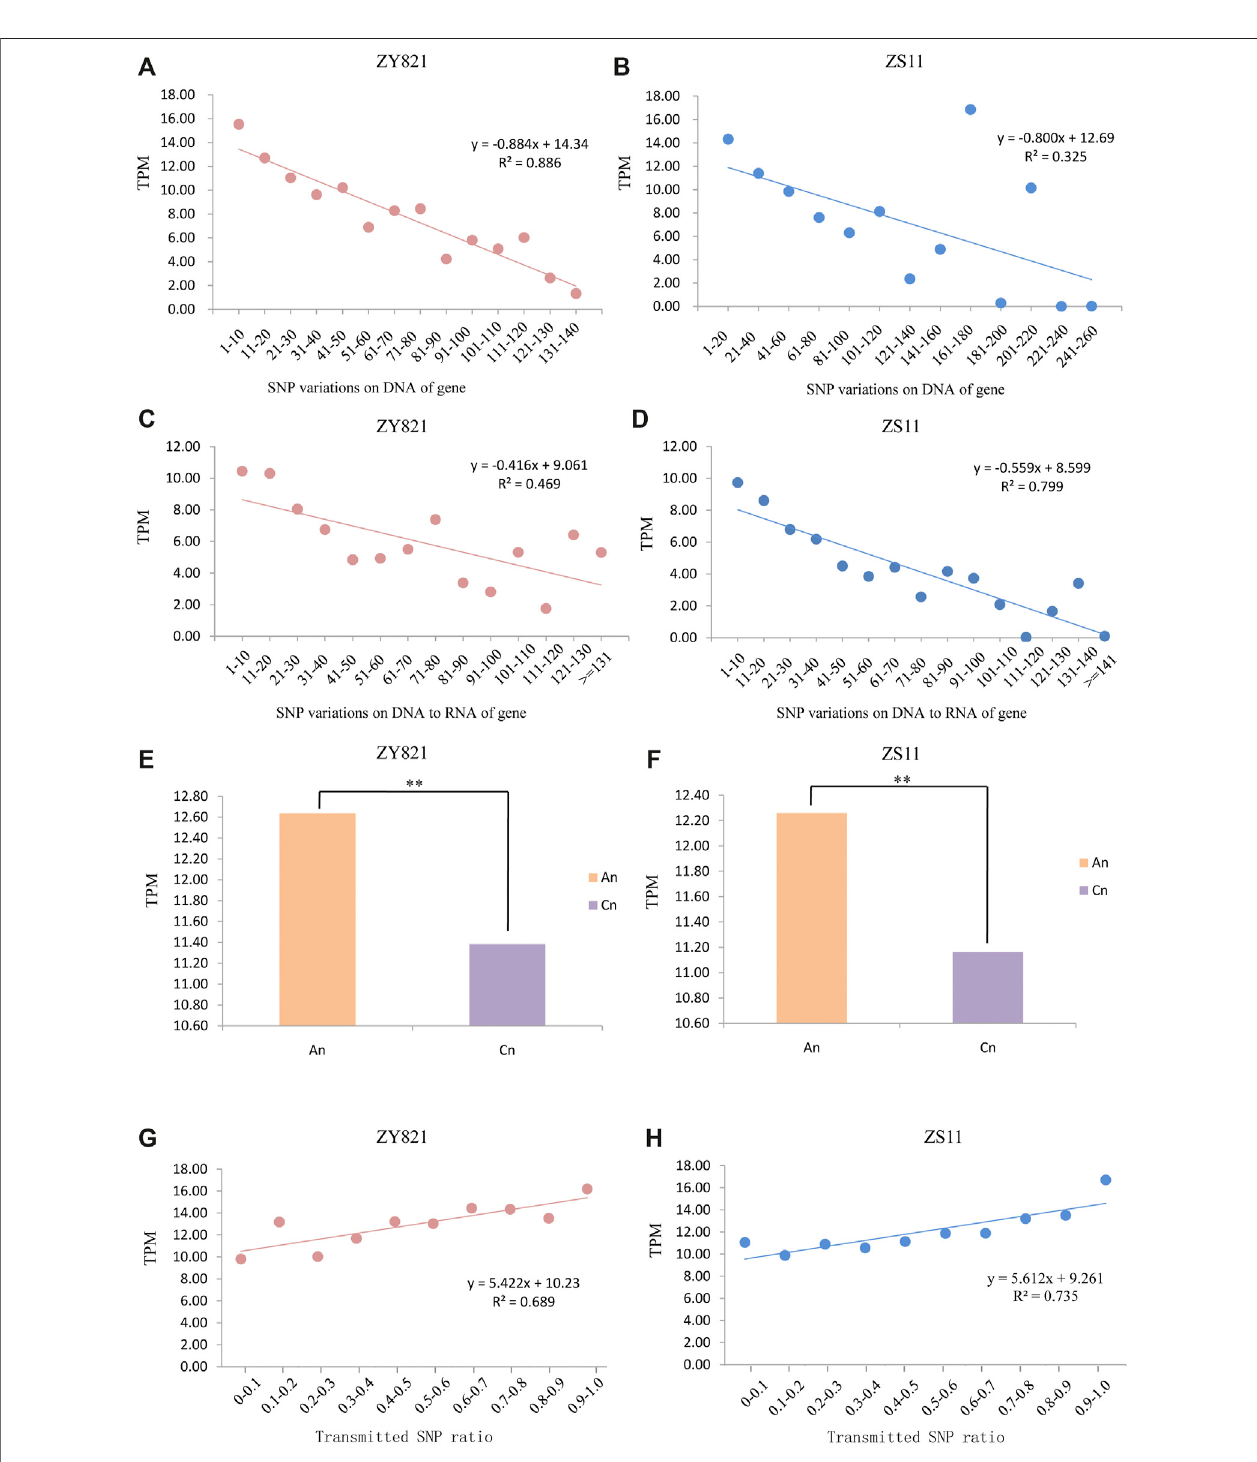
FIGURE 4 | Correlations of the gene expression levels with SNP variations and transmission ratio Correlations and linear regression between gene expression (TPM) and numbers of genomic SNP in all ZY821 (A) and ZS11 (B) genes. Correlations and linear regression analyzes between TPM and numbers of novel SNP variations on DNA to RNA of gene in ZY821 (C) and ZS11 (D) . Average expression levels of all syntenic genes in A n and C n in ZY821 (E) and ZS11 (F) , ** represent p < 0.01. Correlations and linear regression analyzes between TPM and ratios of SNPs of all genes transmitted from DNA to RNA in ZY821 (G) and ZS11 (H) .